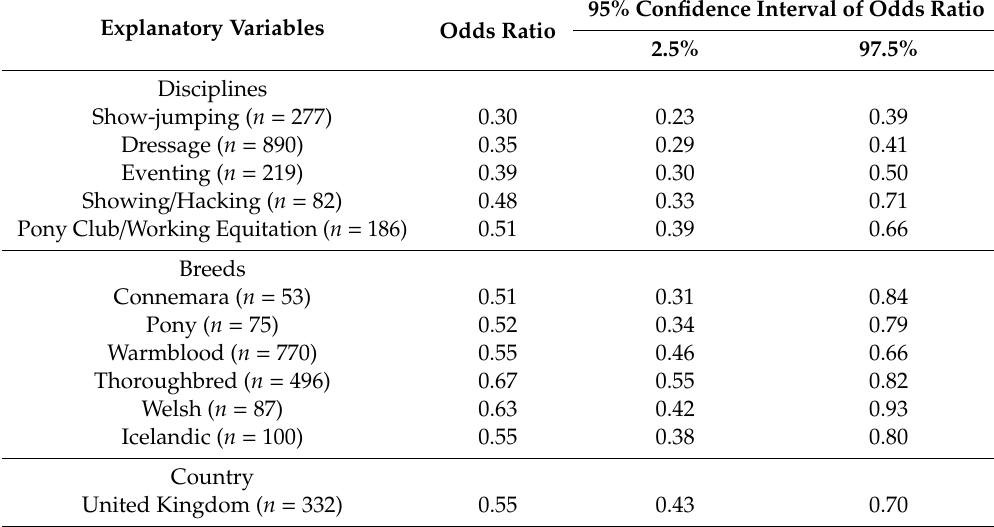
Table 2. Explanatory variables (equestrian disciplines, horse breeds and country of origin) associated with significantly lower odds of less noseband use compared with the study